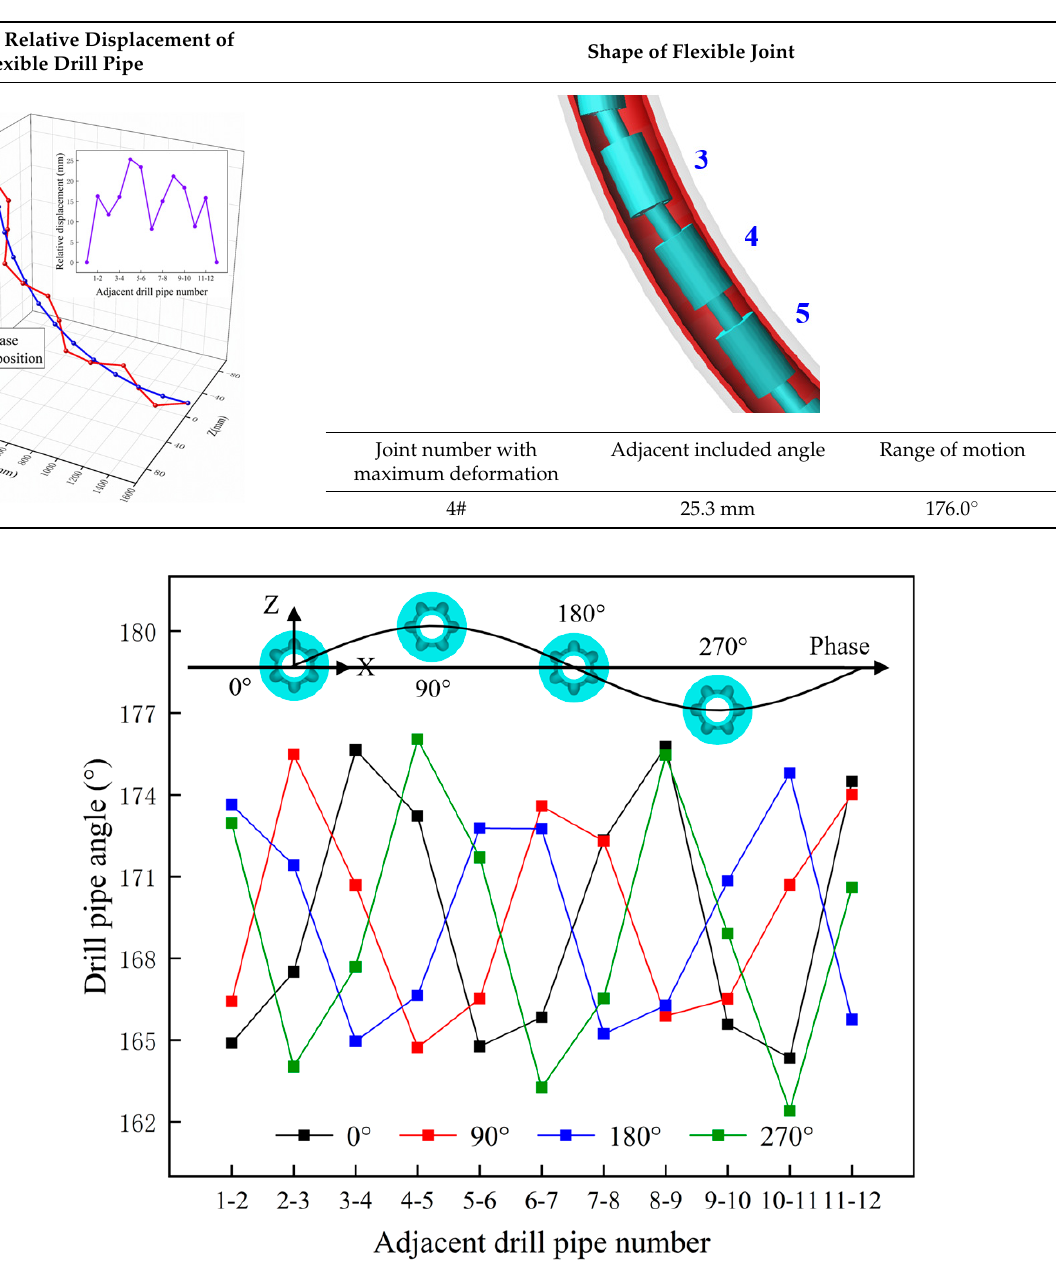
3.2. Analysis of the Contact between the Flexible Joint and the Guide Tube